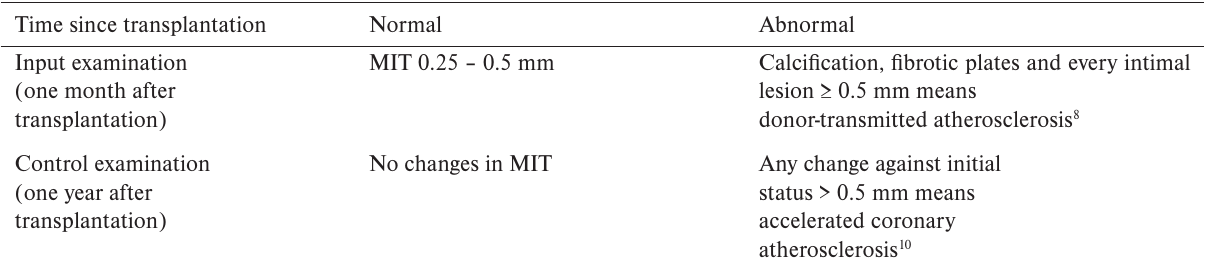
Table 1. Basic interpretation criteria for intravascular ultrasound measurements after HTx. Time since transplantation